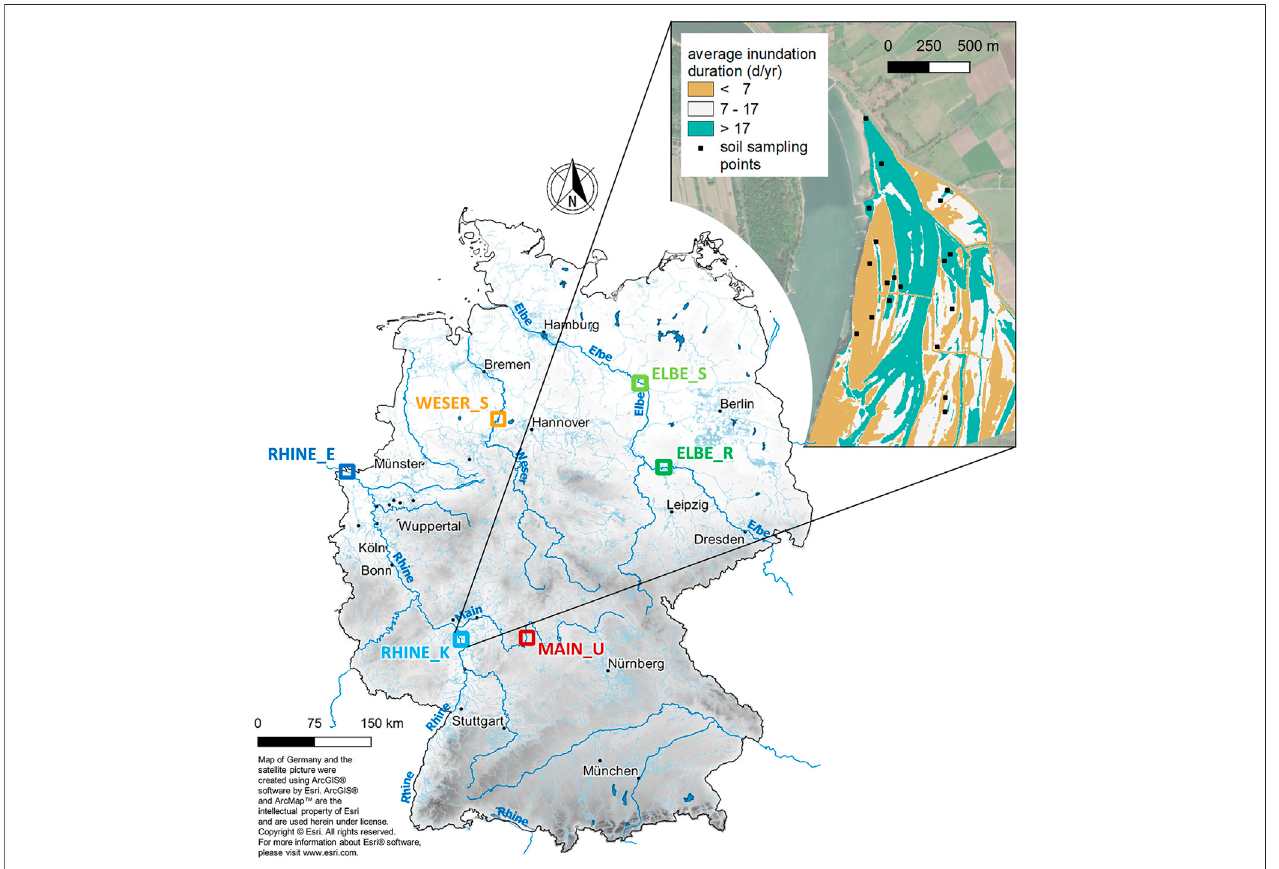
FIGURE1| Locationofthestudyareasinthesix fl oodplains[Elbe_R(ER),Elbe_S(ES),Weser_S(WS),Main_U(MU),Rhine_E(RE),Rhine_K(RK)]inGermanywitha detailed view of RK, located in the Upper Rhine region of Germany.